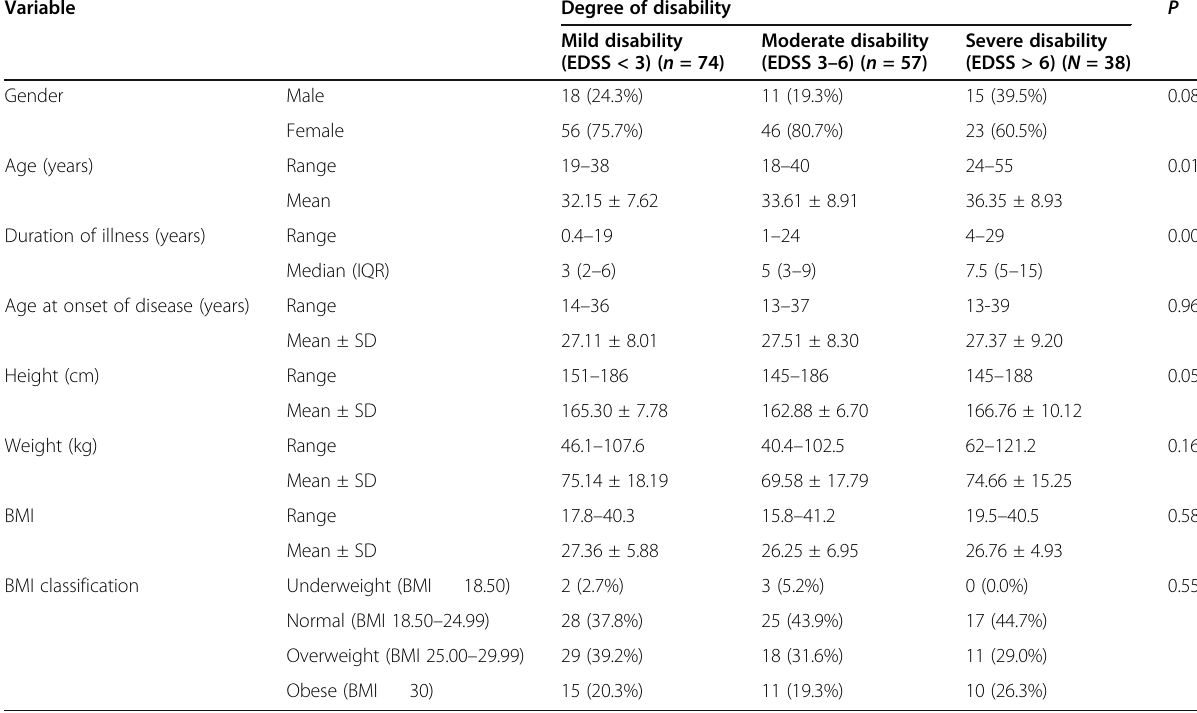
Table 2 Correlation between the degree of disability and demographic data, clinical characteristics, height, weight, and BMI Variable